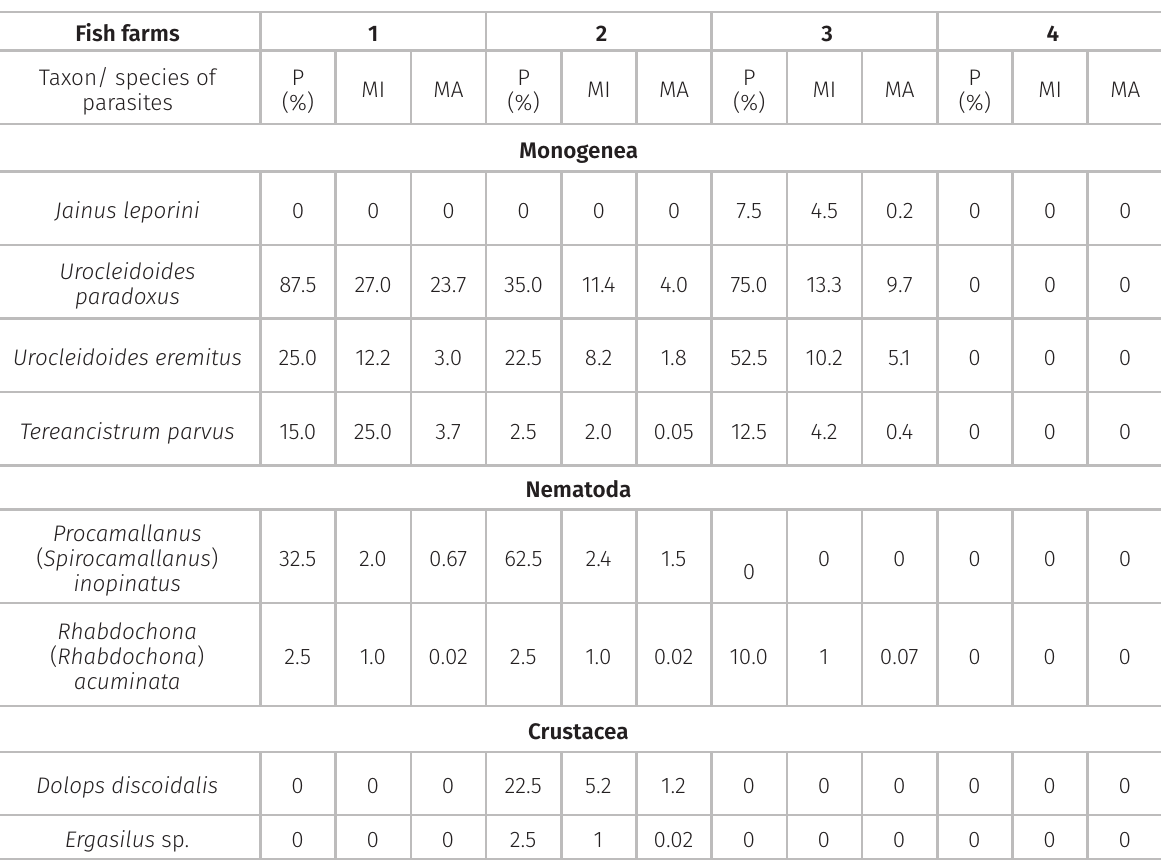
Table III. Parasites in Leporinus macrocephalus of four fish farms from the Rio Branco, in State of Acre, western Amazon region